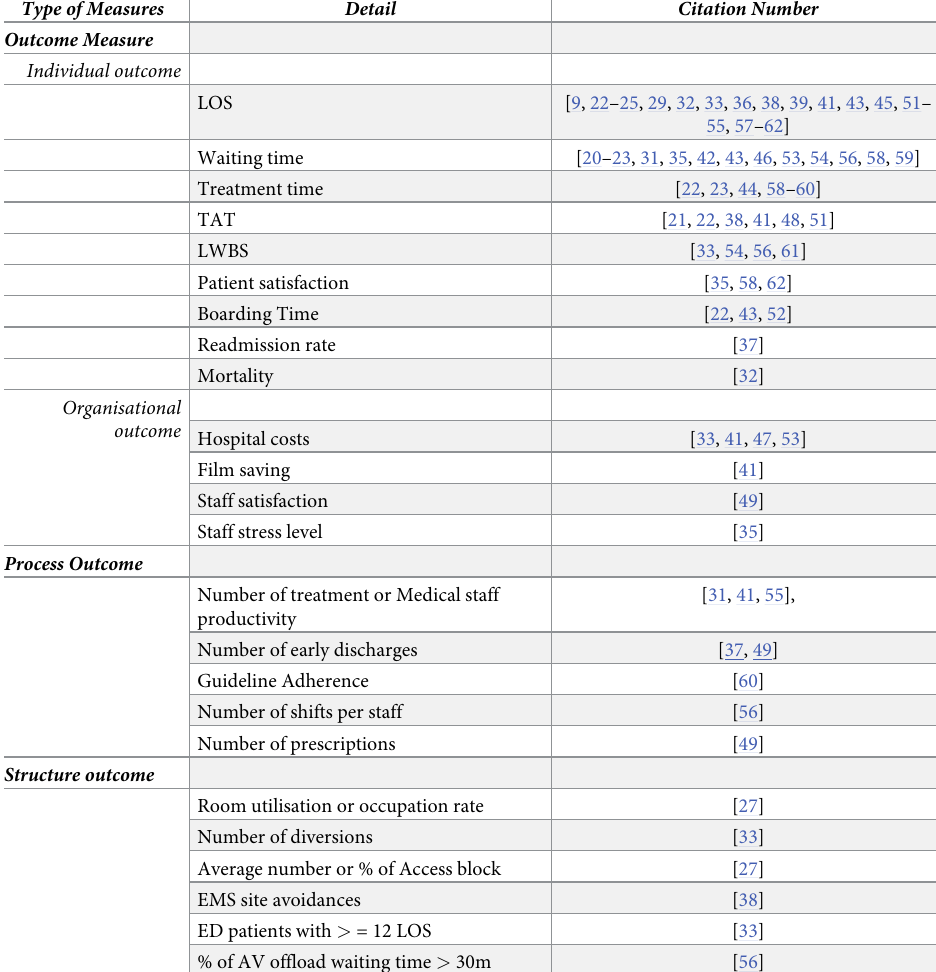
Table 5. Patient flow measures and the citation number of included